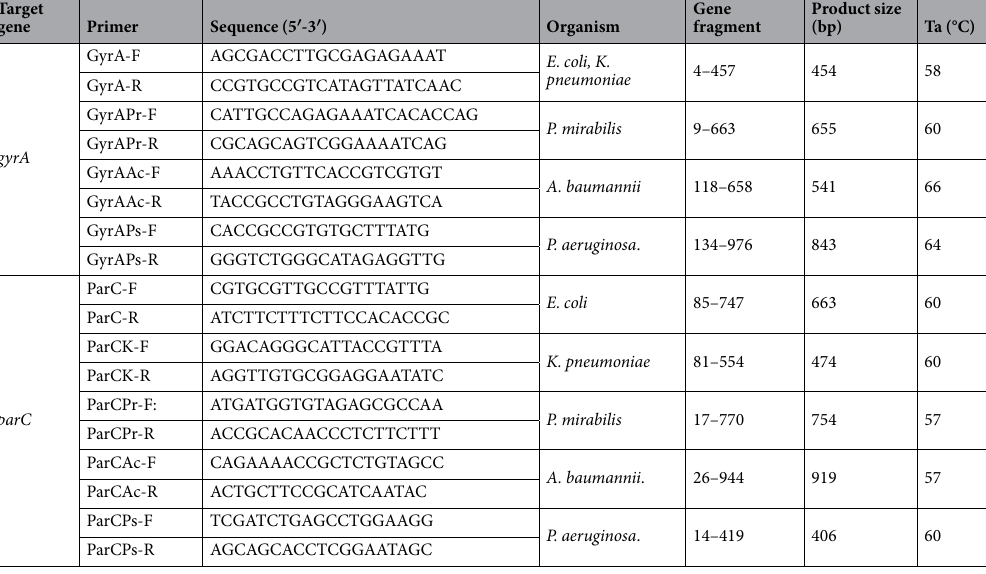
Table 4. Primers used for amplification of gyrA and parC genes from various species. Ta, annealing